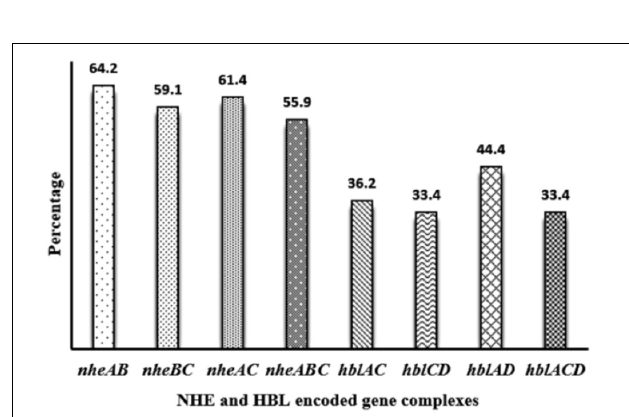
FIGURE 3 | Distribution of toxin gene of Bacillus spp. isolated from animal feed, animal-derived products, and human stool in Bangladesh. The number at the top of the bars represents the positive rate of the corresponding toxin genes. “All eight genes” presents the strains containing all the detected toxin genes.